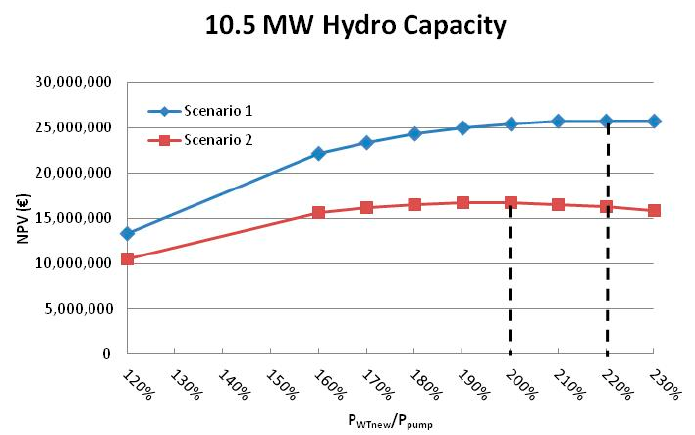
Figure 8. Comparison of the two billing scenarios considering P hydro = 10.5 MW.